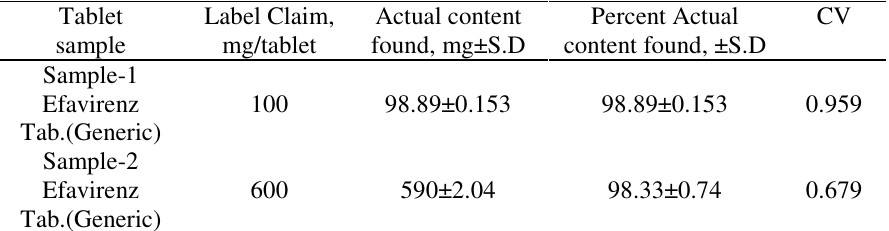
Table 4 . Efavirenz estimation in dosage form by developed method.